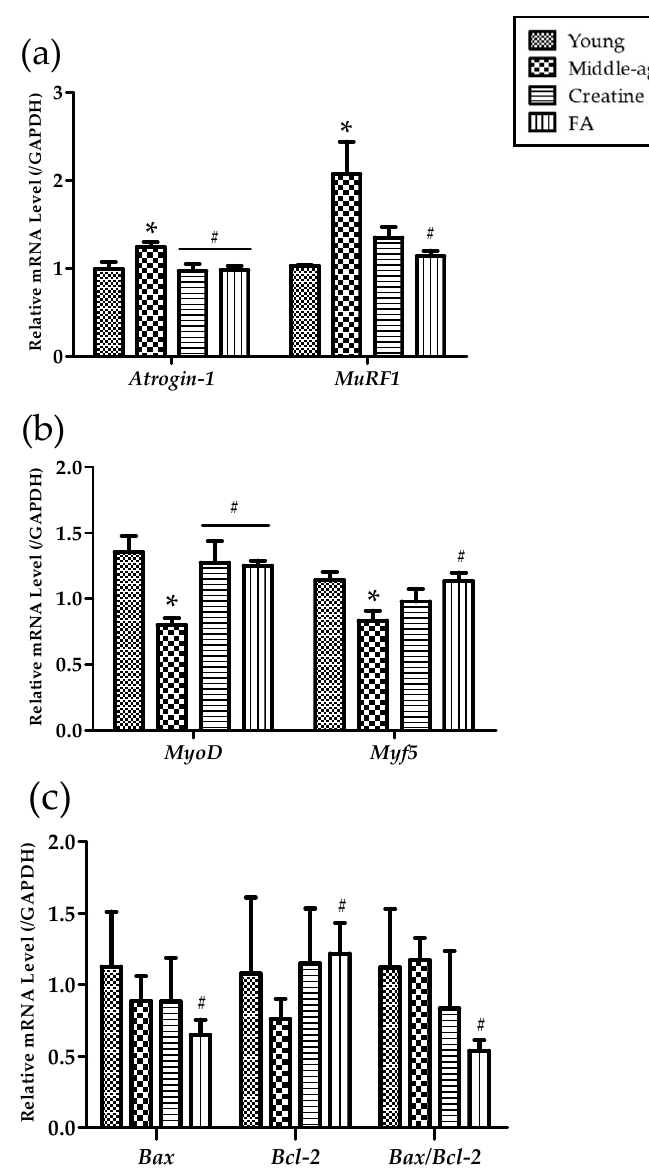
Figure 5. Gene expression in soleus muscle tissue related to muscle protein-degradation ( Atrogin-1 and MuRF1 ) ( a ) and protein-synthesis ( MyoD and Myf5 ) ( b ), and apoptosis ( Bax and Bcl-2 ) with the ratio of Bax/Bcl-2 ( c ). FA, fermented antler. Data are expressed as the mean ± SD ( n = 5 mice per group), and p -values < 0.05 (*) as compared with the young control or p -values < 0.05 (#) as compared with the middle-aged control mice.